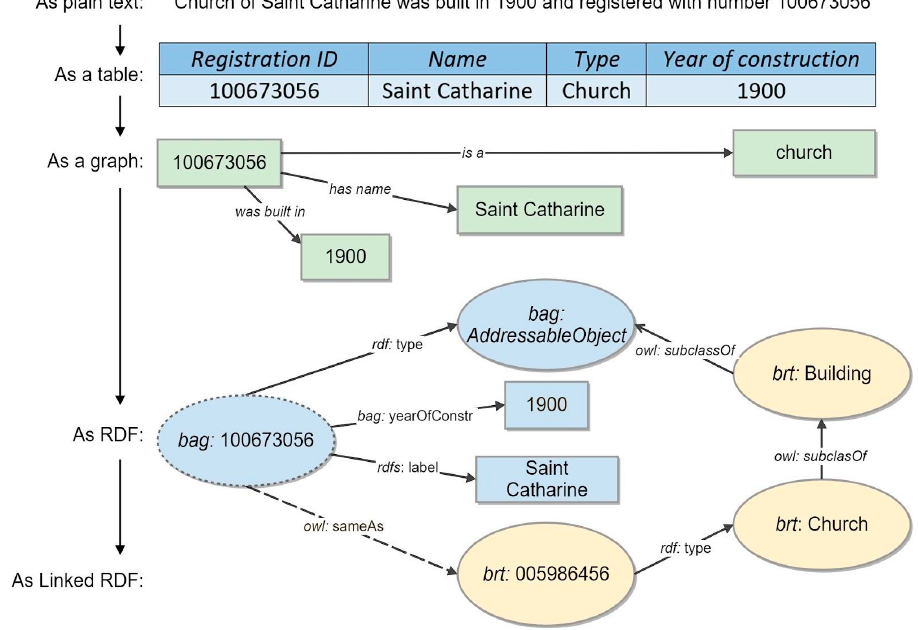
Figure 3. The population of a Knowledge Graph with statements from different registries. The data are firstly translated in graph version and then turned into Linked Resource Description Framework (RDF). After [30].